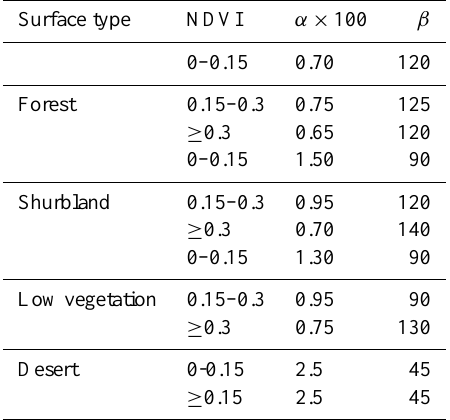
Table 4. Detailed parameters of Nadal and Breon model. Surface type